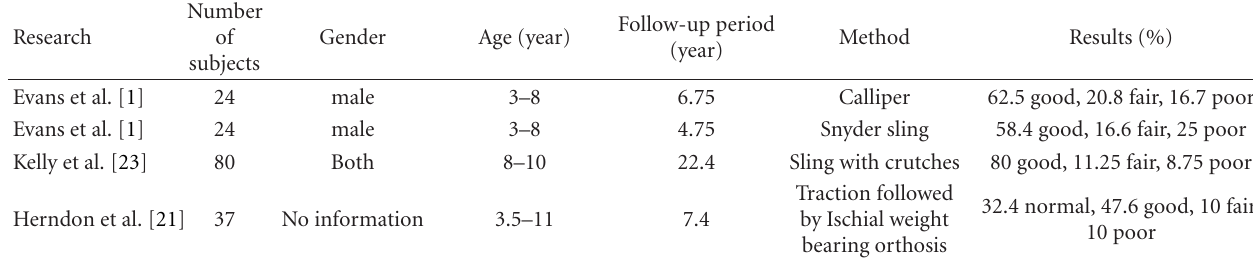
Table 5: Results of noncontainment